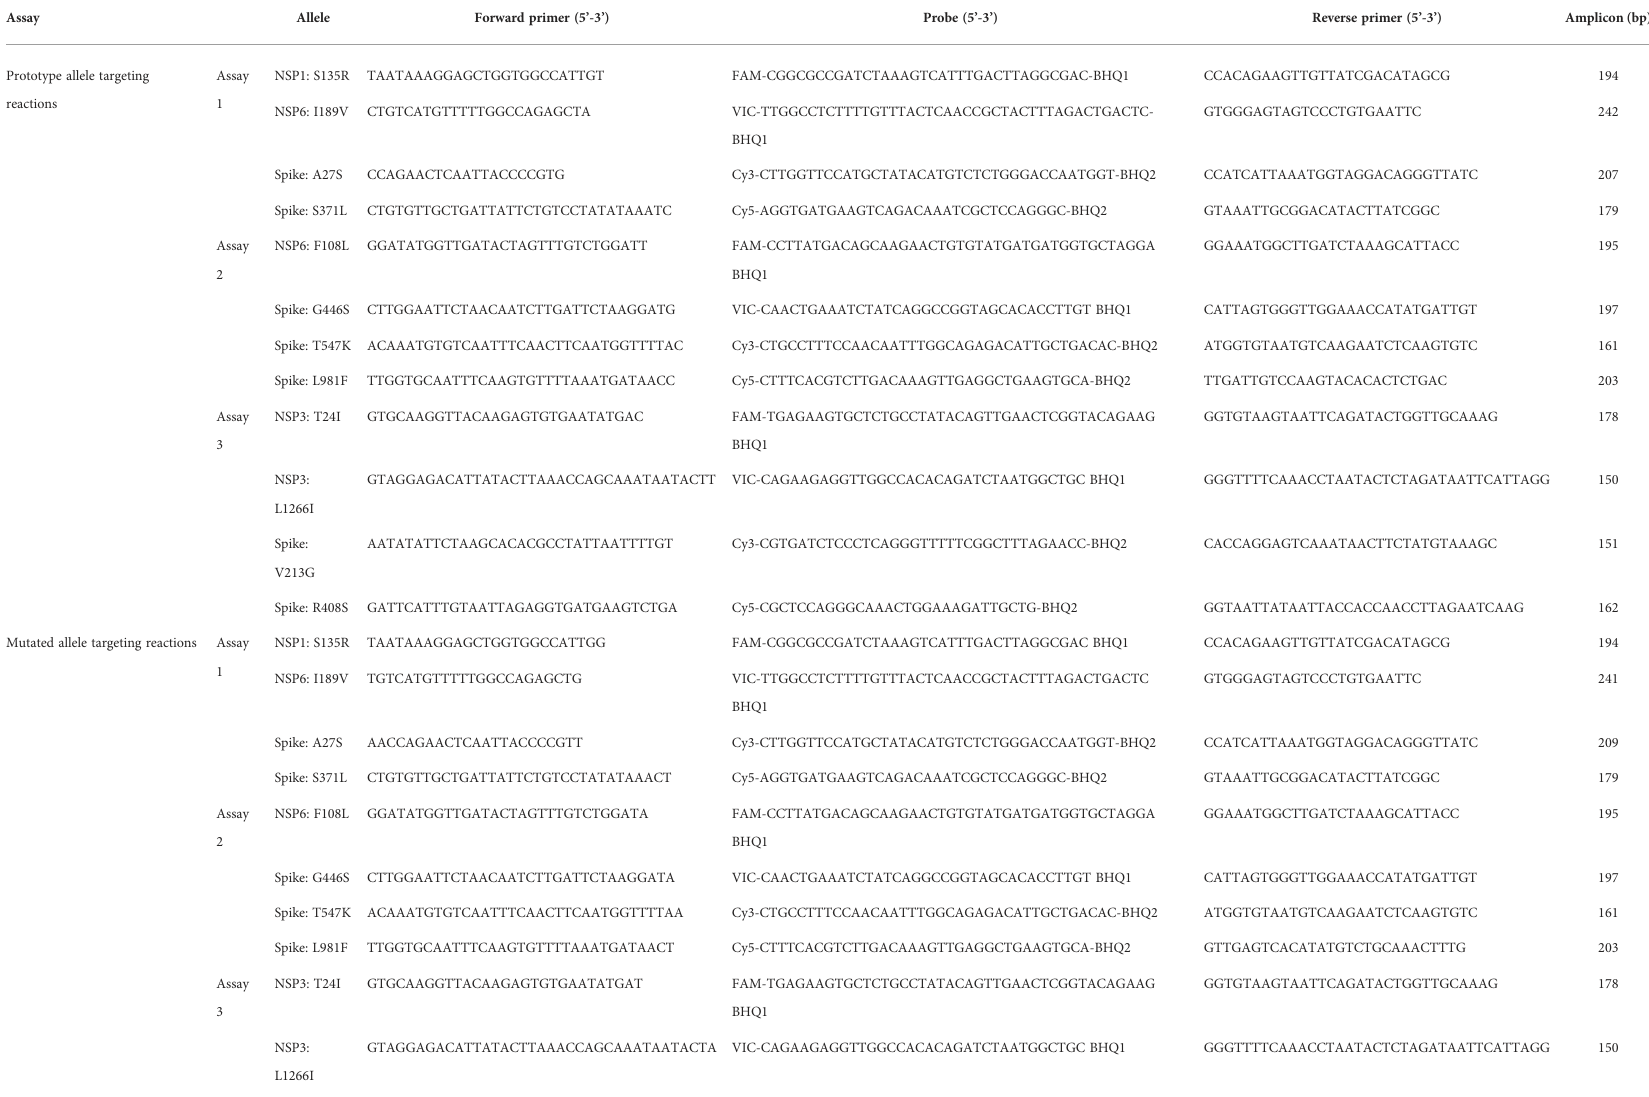
TABLE 1 Primers & probes for the developed multiplex allele-speci fi c qRT-PCR